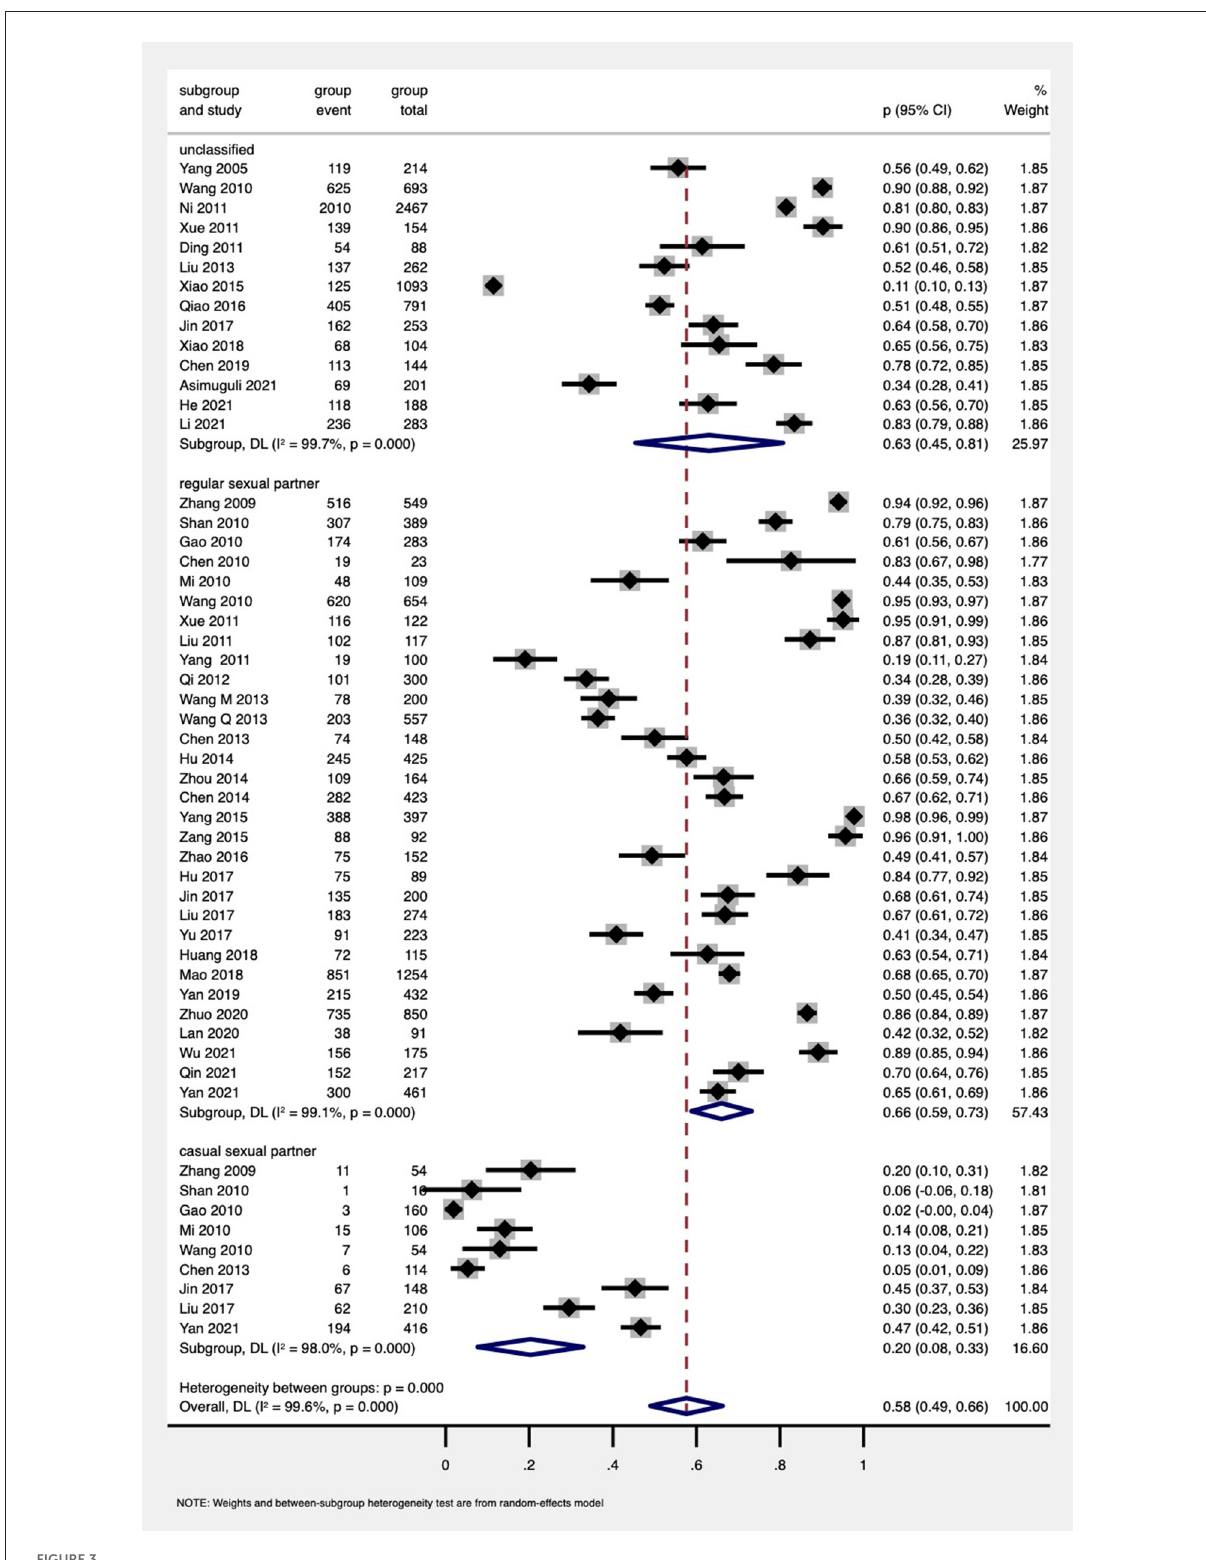
FIGURE3 Forest plot of subgroup analysis by types of sexual partners among